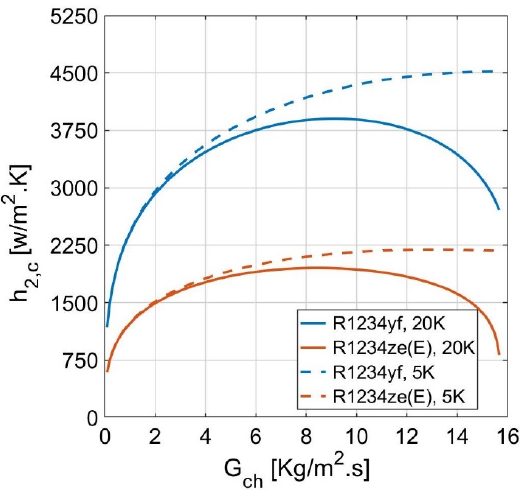
Figure 12. Cold stream two-phase convection coefficient at various cold channel mass fluxes and different superheat temperature differences.